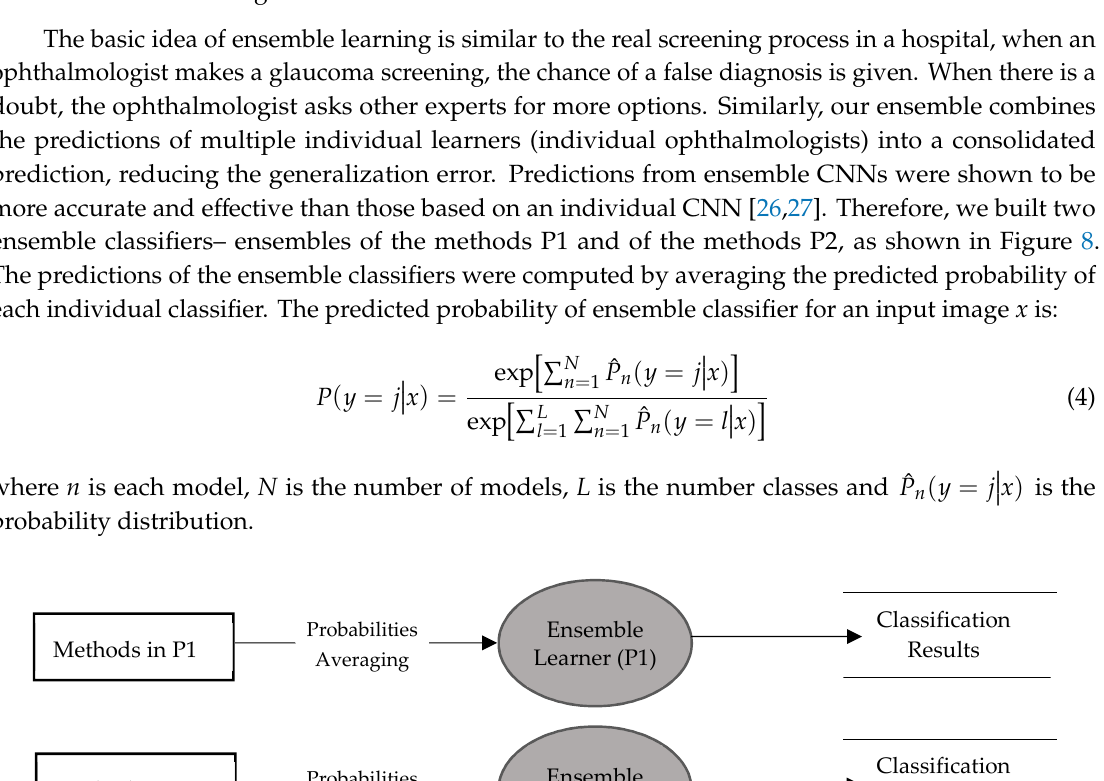
Figure 7. Visualization of the feature maps for two convolutional layers: ( a ) Input Cropped-OD image; ( b ) conv1 and ( c ) conv32 generated by DenseNet.